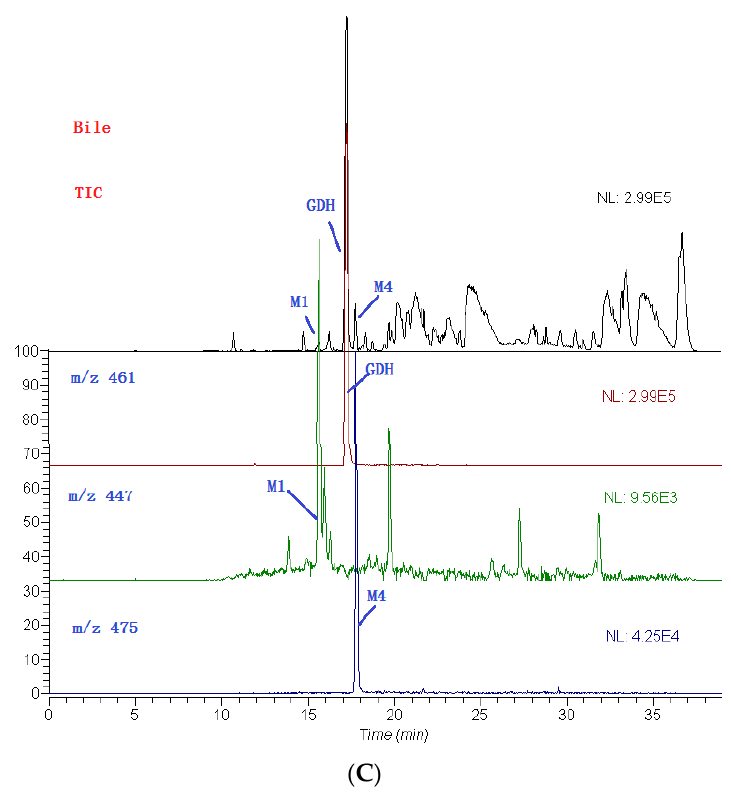
Figure 3. Extracted ion chromatograms for rat metabolites of DF3G in feces ( A ); urine ( B ) and bile ( C ) by LC-ESI/MS n analysis.